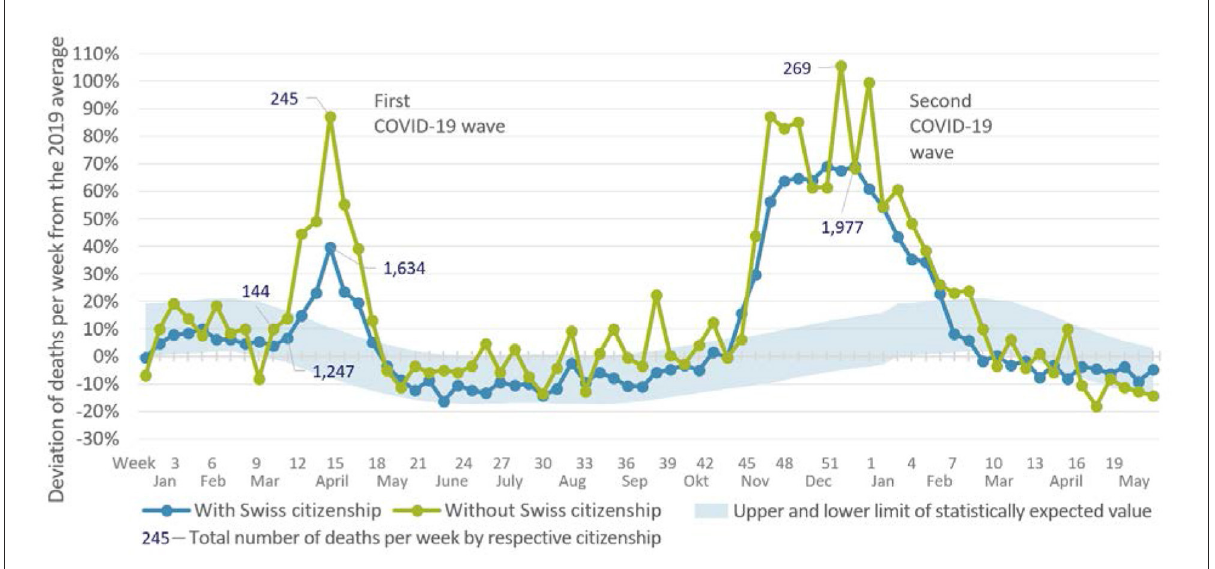
FIGURE2 Changes in weekly deaths in Switzerland from 2020 to May 2021 relative to the average number of deaths per week in the previous year (1,169 people with Swiss citizenship and 131 people without Swiss citizenship). The light blue band represents the number of deaths expected within the framework of random fluctuations, based on the development of the case numbers of all those who died in Switzerland in the previous 10 years. Source: Unpublished data from the Swiss Federal Statistical